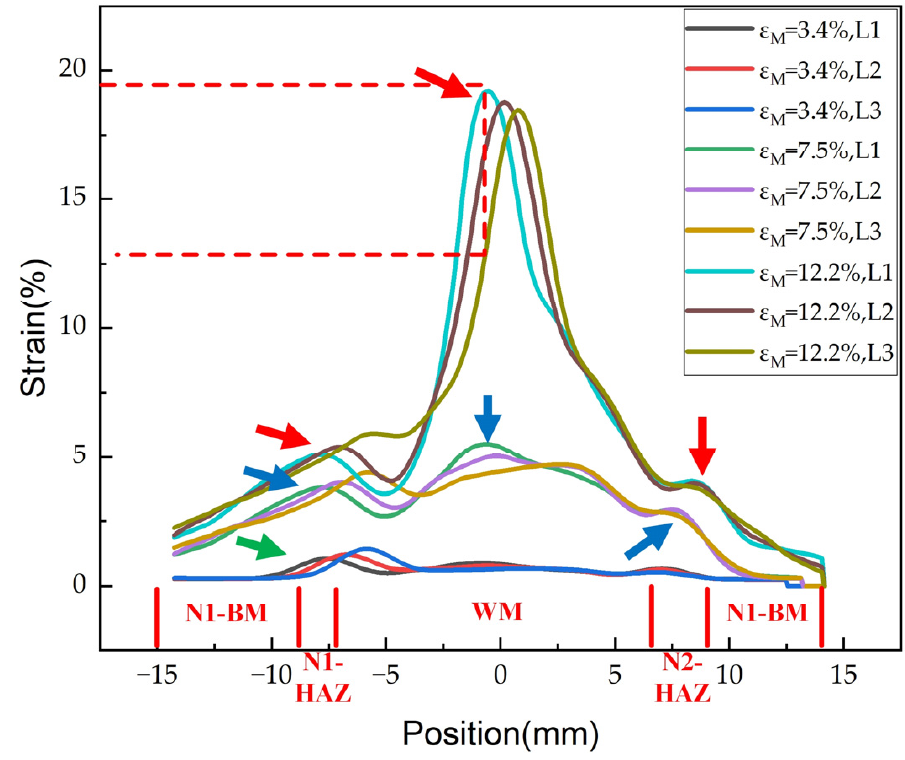
ε ε ε = 3.4%, M = 7.5%, M = 12.2%.